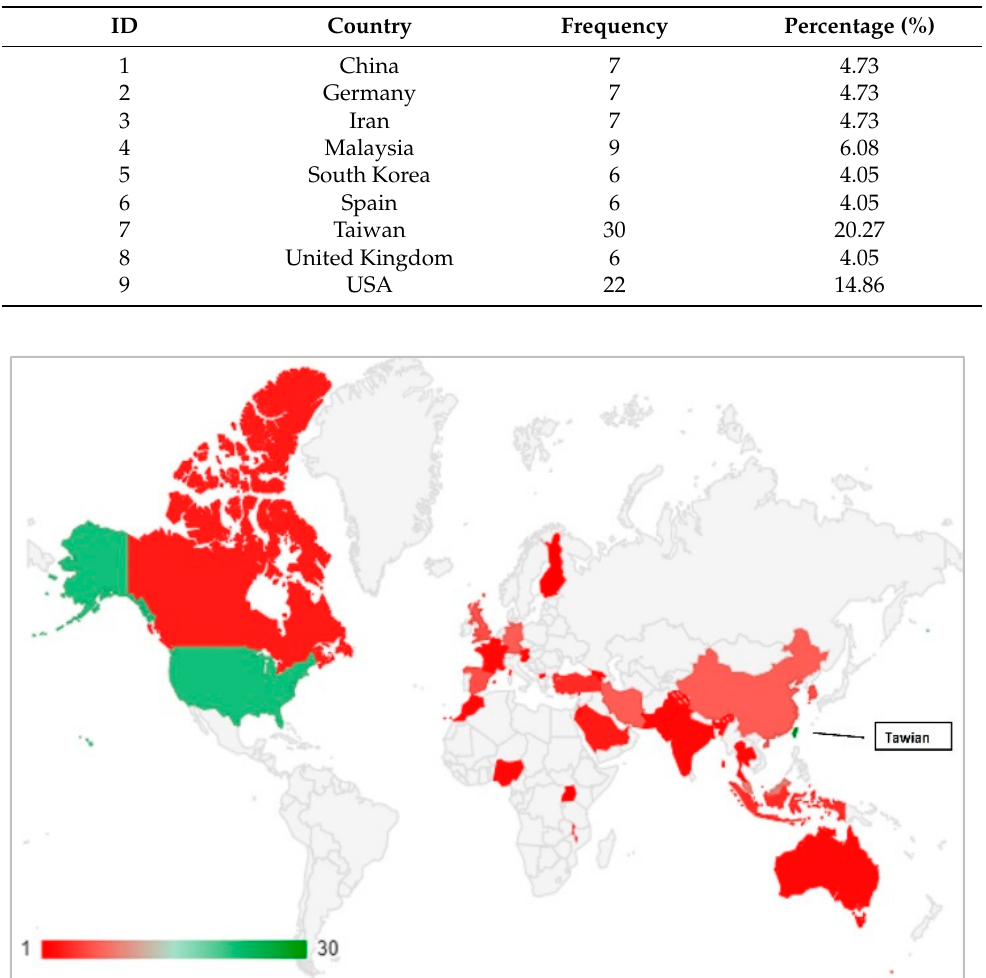
Figure 7. Publications statistics per region. Mixed: conducted in two different regions. Table 7. Top countries by publication frequency.